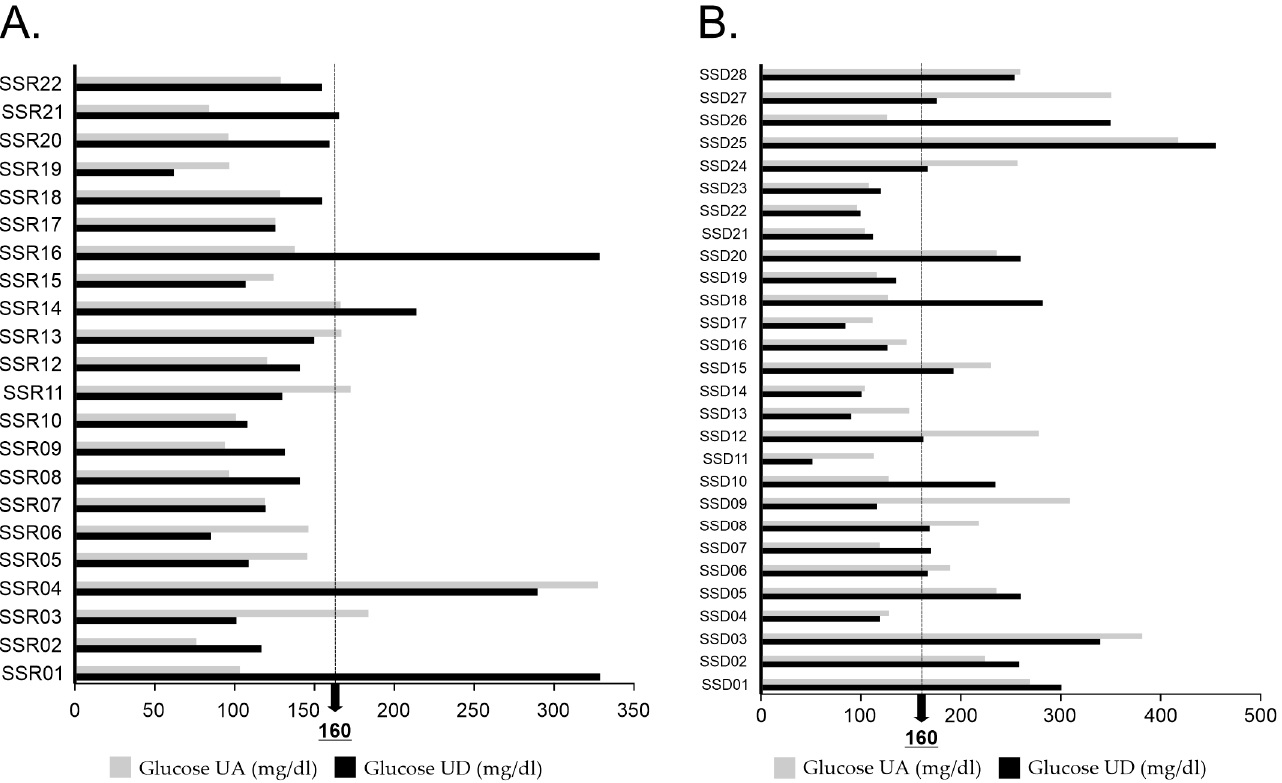
Figure 1. Glucose levels in the study population classified as patients who recovered ( A ) and patients who died due to COVID-19 complications ( B ). Both groups had a high prevalence of hyperglycemia upon admission; most patients who died (60.7%) had sustained hyperglycemia ≥ 160 mg/dL even with insulin treatment. The majority of recovered patients (77.3%) had glucose levels <160 mg/dL upon discharge. SSD, study subject deceased; SSR, study subject recovered; UA, upon admission; UD, upon discharge.